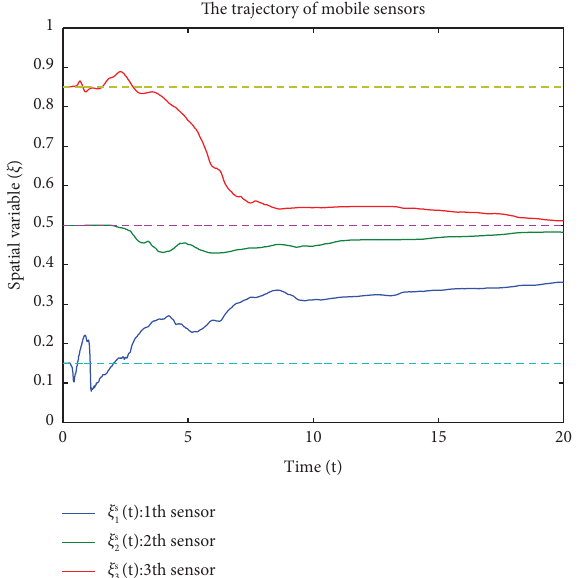
Figure 8: Te trajectories of three mobile